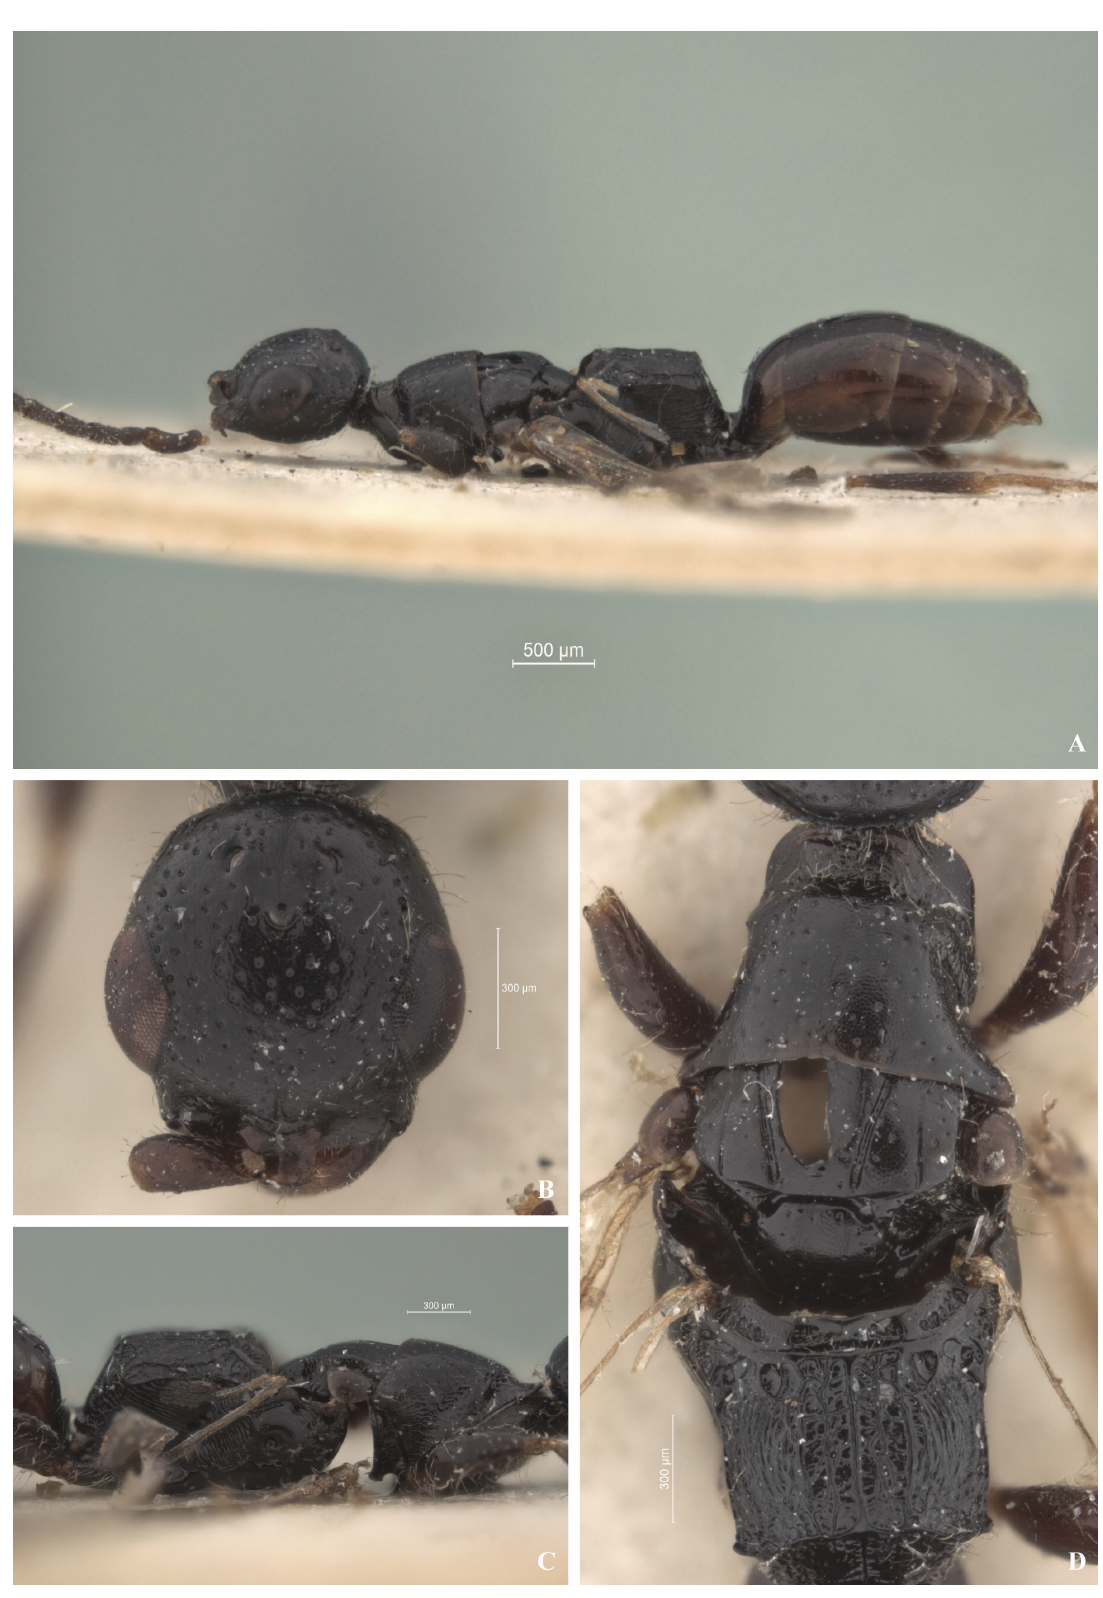
Fig. 3. Bradepyris baleariensis sp. nov. Holotype, ♂. A . Lateral habitus. B . Head in dorsal profile. C. Mesosoma in lateral profile. D . Mesosoma im dorsal